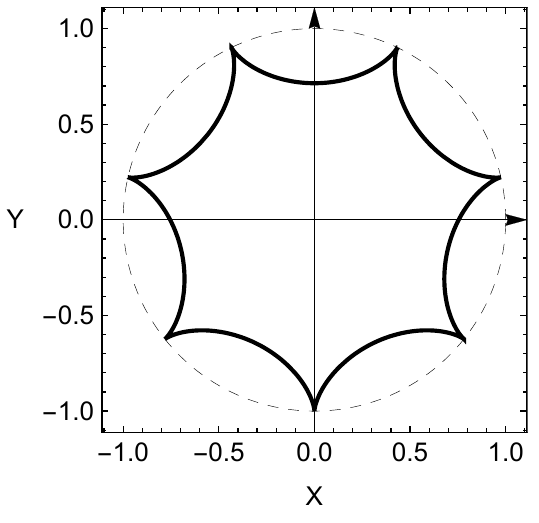
Figure 30: Presentation of paper